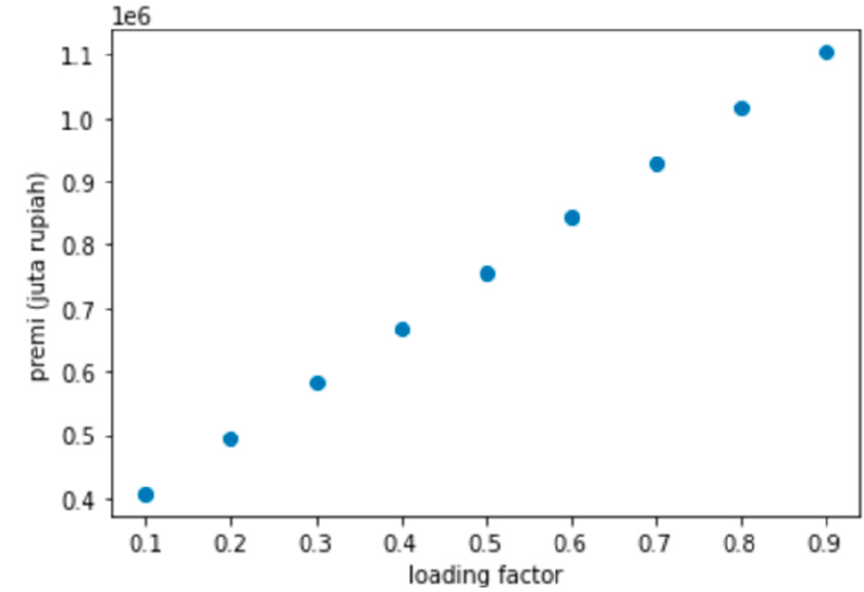
Figure 5. Effect of the loading factor.